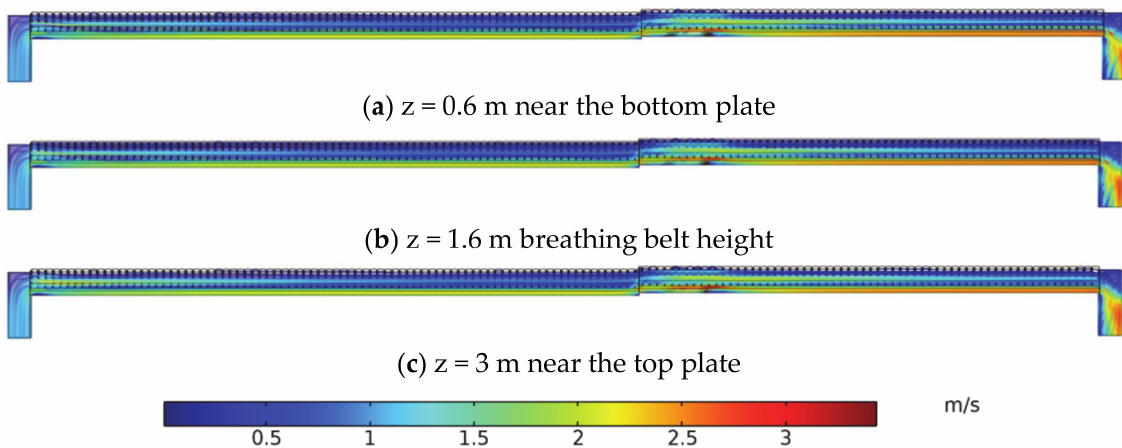
Figure 4. Streamline diagram of the wind flow field at different heights. ( a ) z = 0.6 m near the bottom plate; ( b ) z = 1.6 m breathing belt height; ( c ) z = 3 m near the top